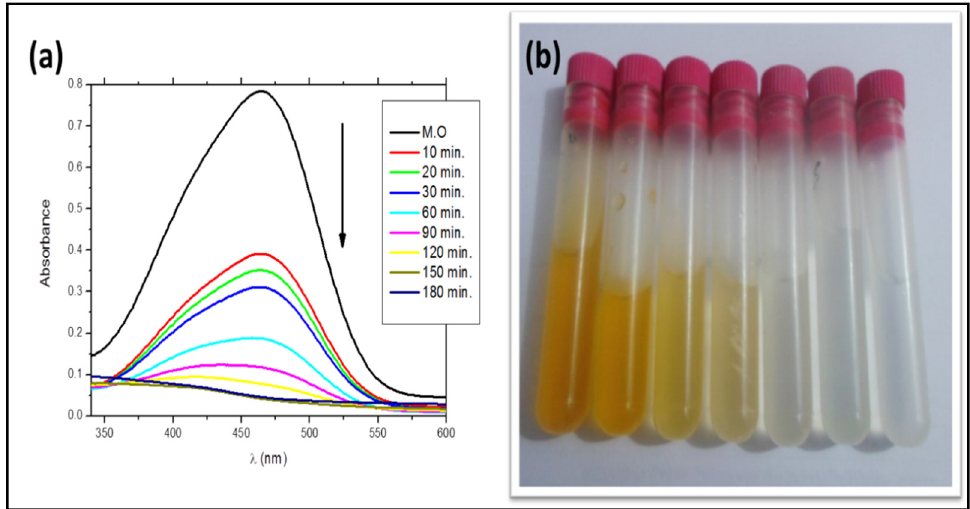
Figure 11. ( a ) UV–Vis absorption spectra for photocatalytic degradation of MO dye by SiO 2 NPs; ( b ) photographic image for MO dye color removal using SiO 2 NPs.